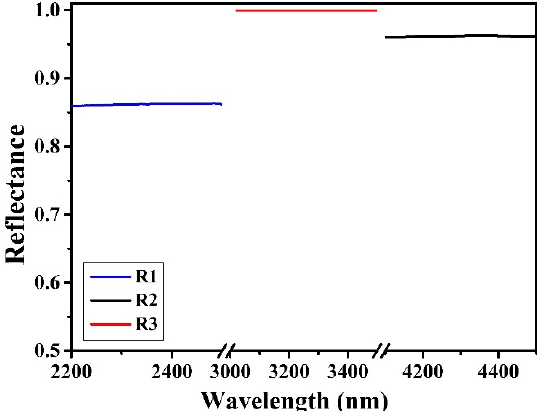
Figure 2. Simulated reflectance curves of the bottom mirrors shown in Figure 1. R1, R2, and R3 are the reflectance of bottom mirrors of FP1, FP2, and FP3, respectively.